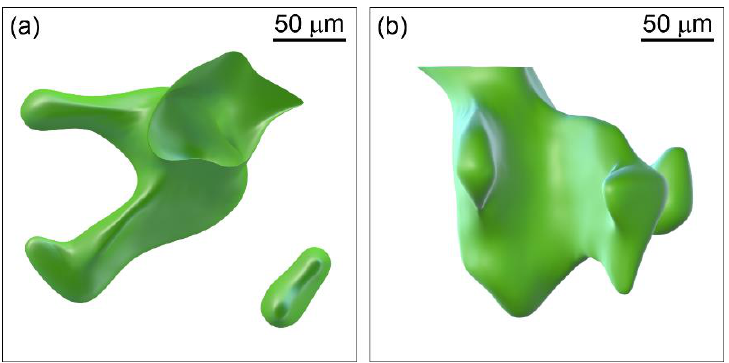
Figure 4. 3D reconstruction of as-grown domains in the vicinity of the polar surface in nominally pure CVO, obtained from the data presented in Figure 4. ( a ) Top view, ( b ) side view. Video S1, Supplementary Materials.